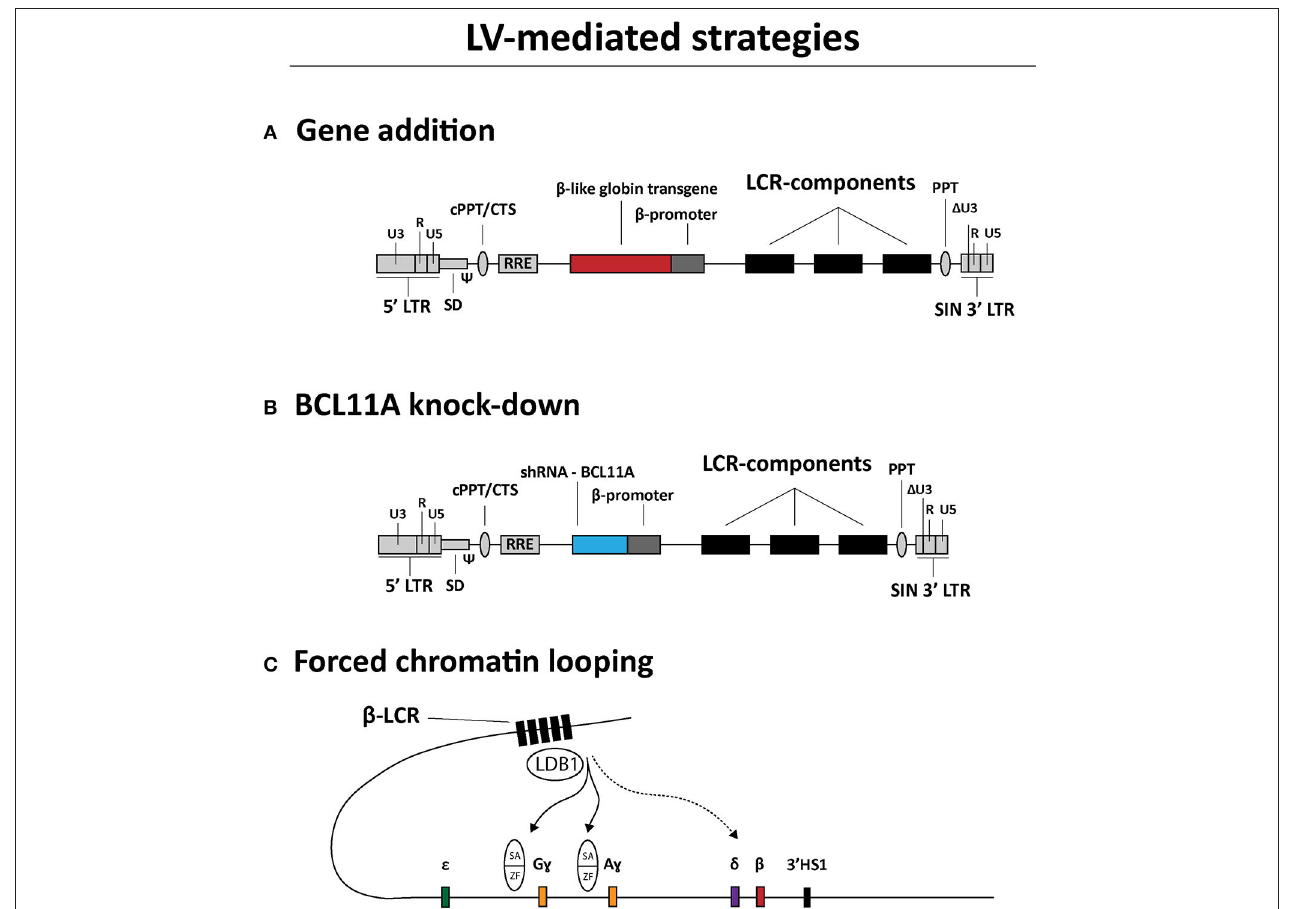
FIGURE 3 | Overview of LV-based gene therapy strategies currently under investigation for the genetic correction of β -hemoglobinopathies. (A) Gene addition. Structure of a LV construct for transgene addition relying on the expression of β -like globin chains to rebalance α -chain to non- α -chain ratios. (B) BCL11A knock-down. Structure of a LV construct for relieving È -globin repression through shRNA-BCL11A-mediated BCL11A knockdown. (C) Forced chromatin looping. Directed loop-formation by LV-mediated delivery of fusion products between LDB1 self-association (SA) domains and zinc-finger (ZF) arrays targeting the HBG2 and HBG1 promoter sequences to up-regulate G È - and A È -globin synthesis, respectively. LCR, locus control region; LTR, HIV-1 long terminal repeat; Ψ , HIV-1 packaging signal; RRE, Rev response element; cPPT/CTS, central polypurine tract and central termination sequence; 1 U3, 3’ LTR with U3 deletion for self-inactivation of HIV-1 regulatory sequences upon chromosomal integration of recombinant LV